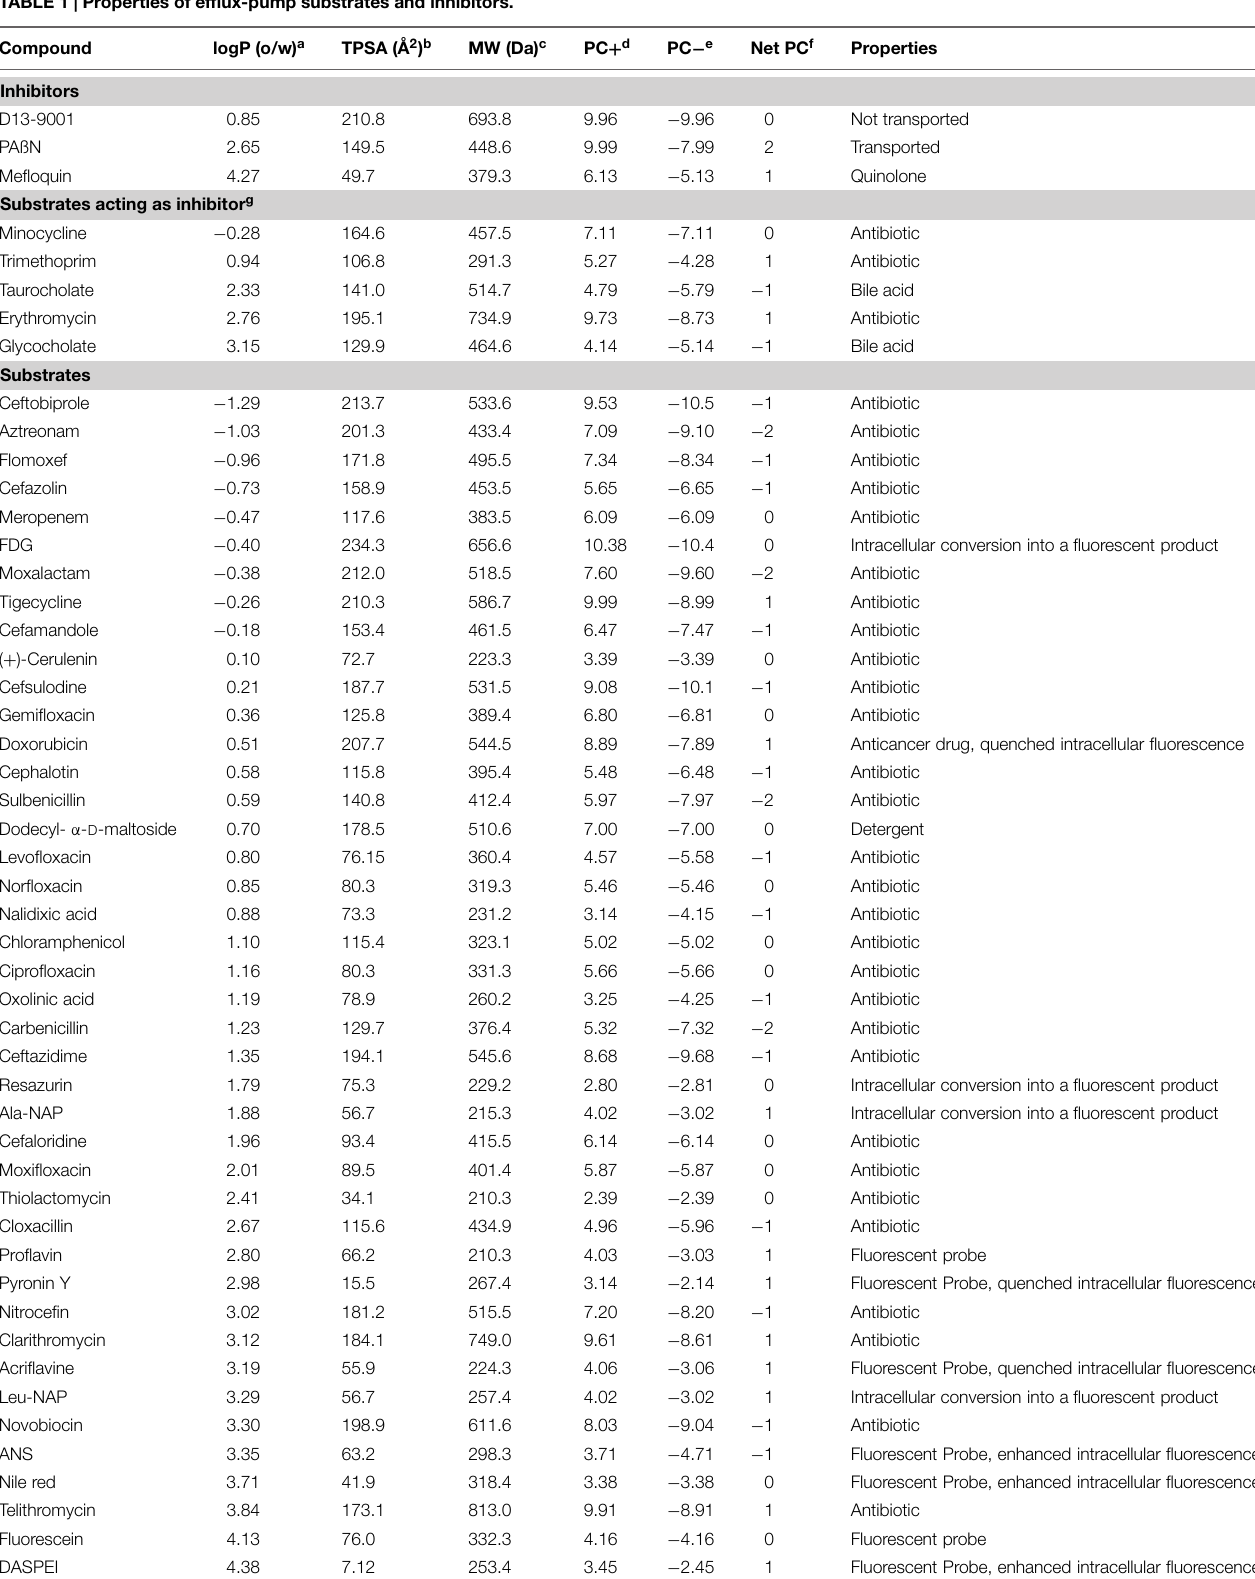
TABLE 1 | Properties of efflux-pump substrates and